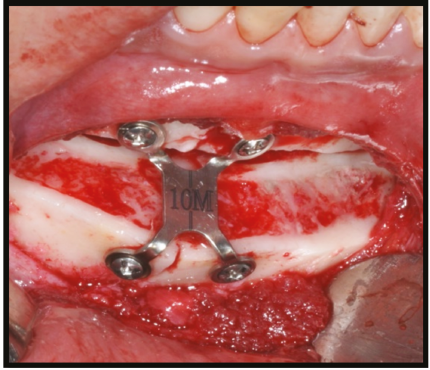
Figure 7: Stable internal fi xation of the chin with a chin plate of 10 mm from the 2.0mm system.